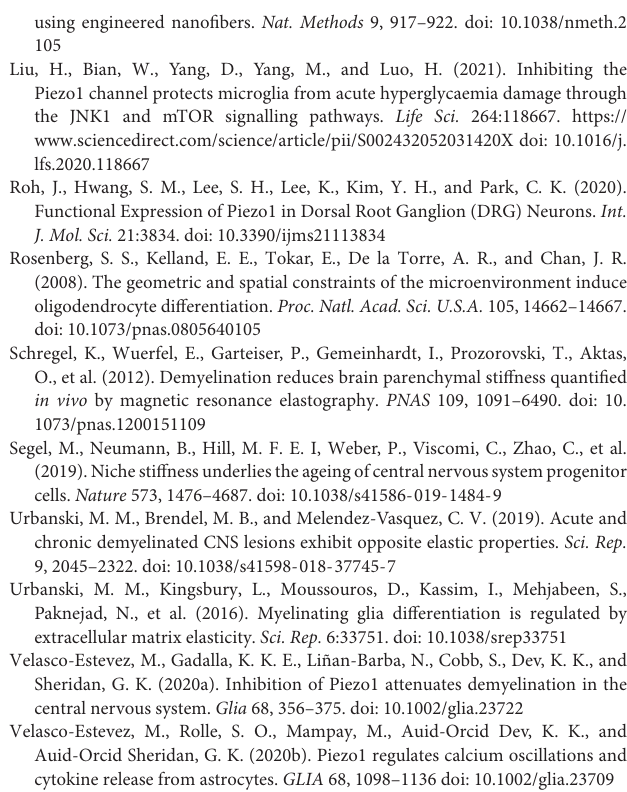
Supplementary Figure 1 | Antibody specificity staining. Representative images of human brain sections immunohistochemically stained with rabbit IgG isotype control antibody for rabbit Piezo1 antibody. Scale 20 µ m. Supplementary Figure 2 | Piezo1 is expressed in oligodendrocyte lineage cells. (A) Human primary OPCs express 50-fold higher mRNA levels of Piezo1 than primary human microglia. Data presented as average of technical duplicates of N = 1 lysates. (B) Dot blot shows Piezo1 protein levels in lysates of primary human neurons, OPCs and MO3.13 oligodendrocytes. Piezo1 protein is present in all three cell types with highest expression in MO3.13 oligodendrocytes. Bar graph shows densitometry quantification of dot blots ( N =